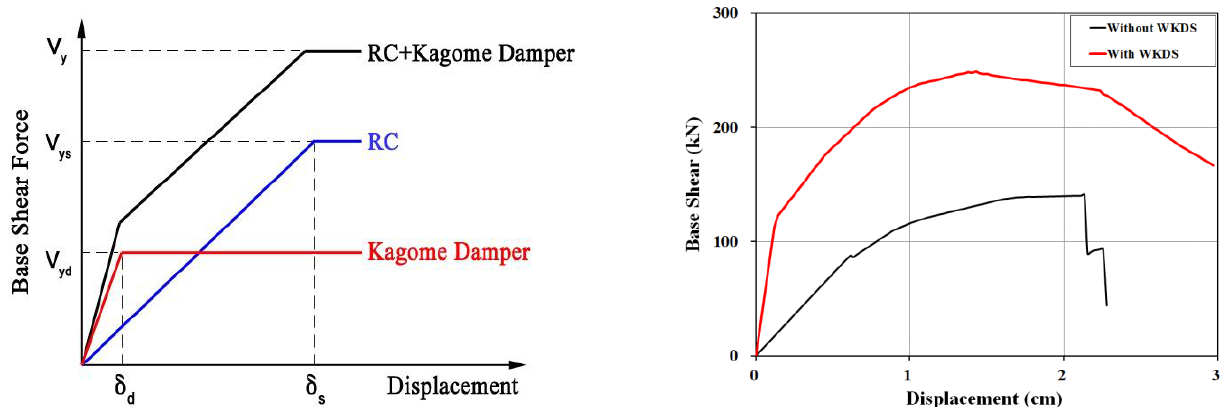
Figure 8. Base shears and displacements of structures with and without